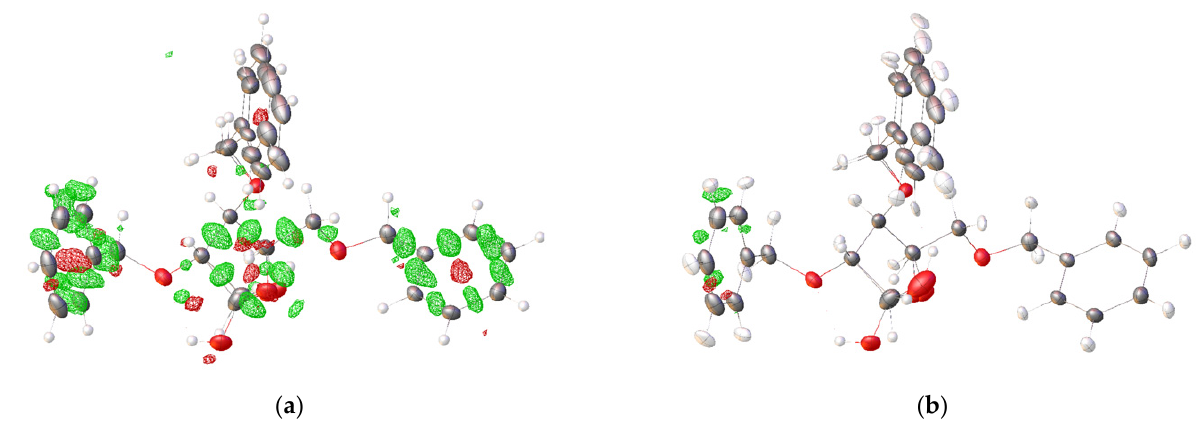
Figure 5. Wire visualizations of the residual electron density maps over the molecular structure of compound 1 after ( a ) IAM and ( b ) HAR refinement. The residual density was calculated with Olex2 from fcf files and plotted on a grid of 0.05 Å with an iso-value of 0.121 eÅ − 3 (0.10 eÅ − 3 , respectively) (green = positive, red = negative).